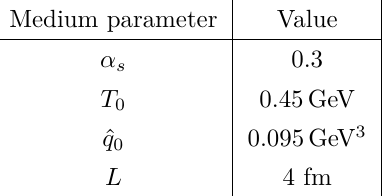
Table 1 . Choice of medium parameters corresponding to 0-10% central PbPb collisions with √ s NN = 5 . 02